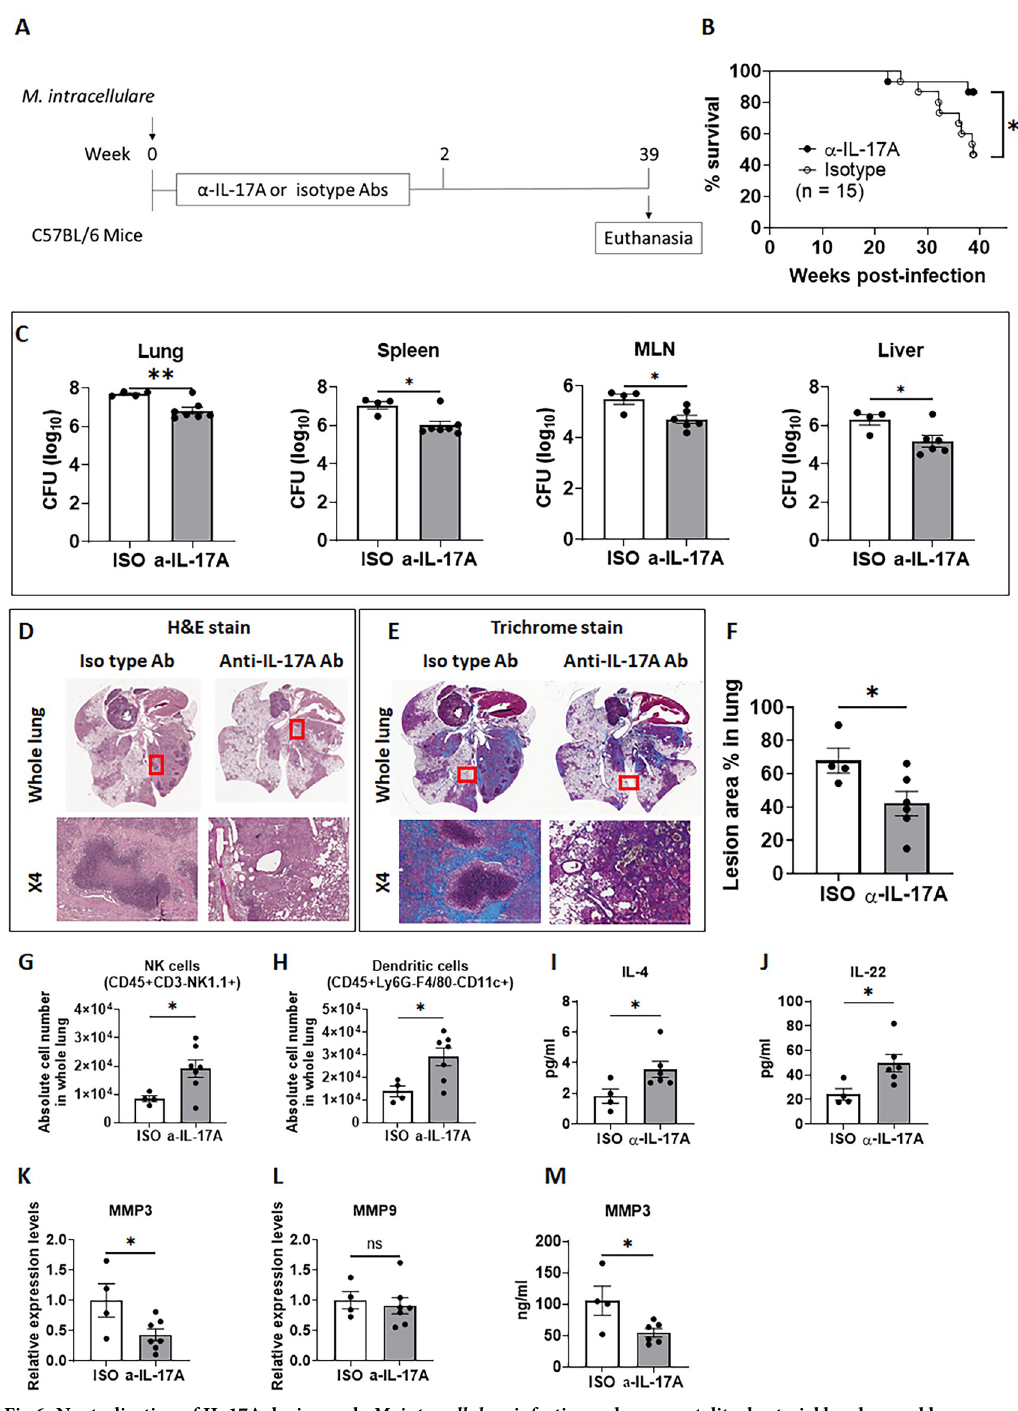
Fig 6. Neutralization of IL-17A during early M . intracellulare infection reduces mortality, bacterial burden, and lung damage in chronically infected mice. ( A ) Schematic representation of M . intracellulare infection and anti-IL-17A mAb or isotype control treatments is shown. Mice were intranasally administered normal saline or M . intracellulare suspension (5 × 10 7 CFU in normal saline). To neutralize IL-17A, M . intracellulare -infected mice were intraperitoneally injected with 100 μ g of anti- IL-17A mAb or 100 μ g of mouse IgG1 isotype control Ab every other day from 1 to 11 days postinfection. ( B ) Survival curves for anti-IL-17A mAb (black circle)- or isotype control (white circle)-treated M . intracellulare -infected mice. Data were pooled from two independent experiments (total n = 15 mice per group). Survival curves were compared using the log rank test. ( C ) Bacterial burden was determined in the lungs, spleen, mediastinal lymph nodes (MLNs), and liver at 39 weeks postinfection. Data were